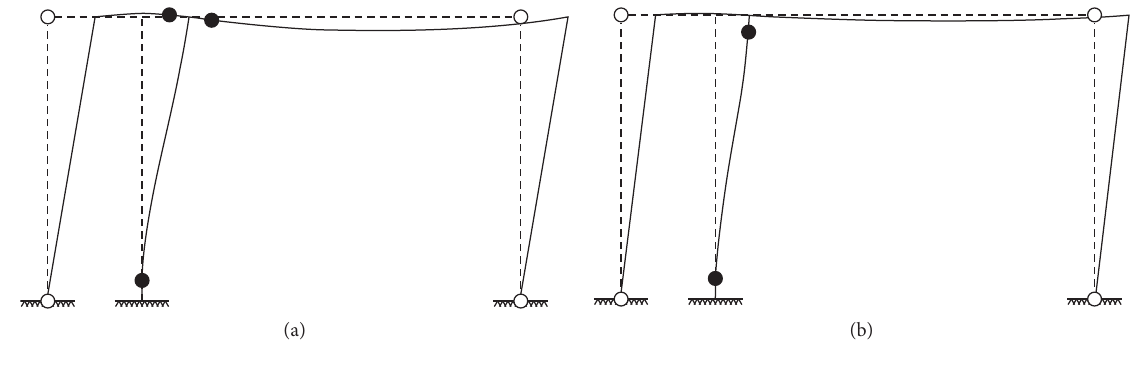
Figure 5: Results of analysis of models (I) and